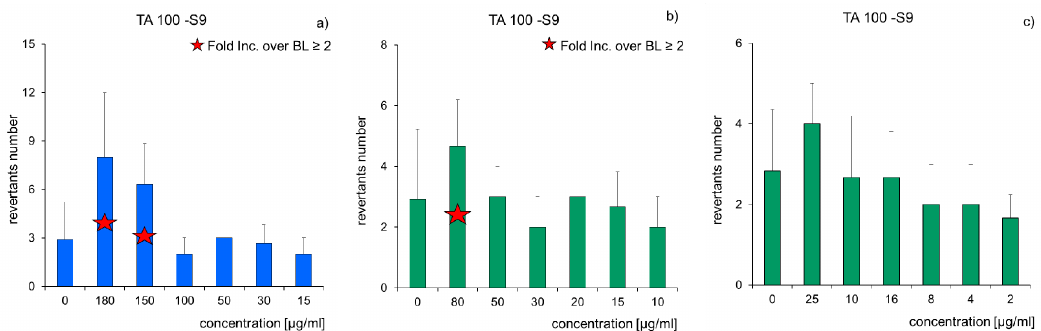
Figure 9. Influence of PCBs and TPH concentration on revertants number ( n = 3, p < 0.05): ( a ) raw soil (Soil D); ( b ) soil after 3-month biodegradation (Soil D3); ( c ) soil after 6-month biodegradation (Soil D6); fold increase over the baseline (mutagenicity index).